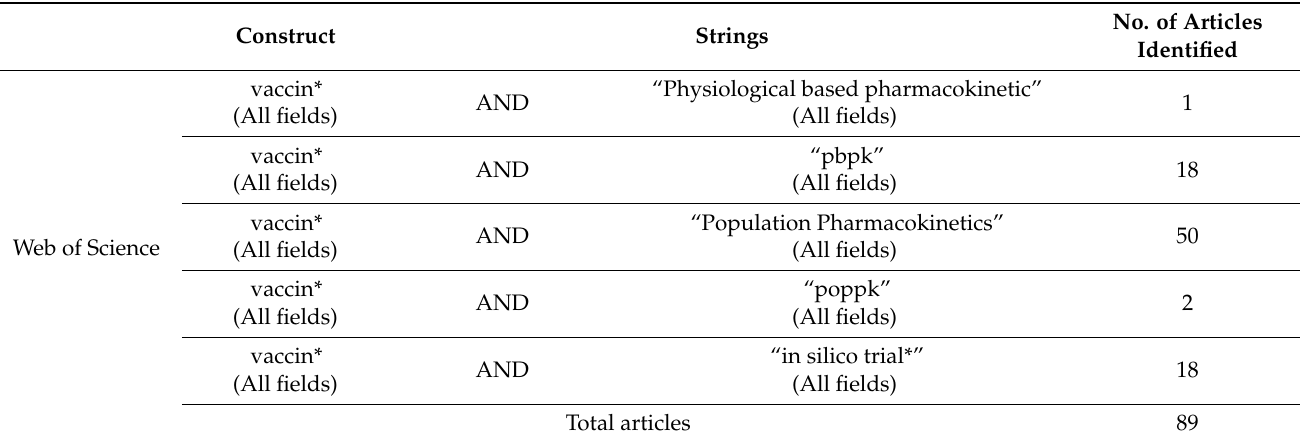
Table 1. Constructs, Strings, and identified articles from WoS and